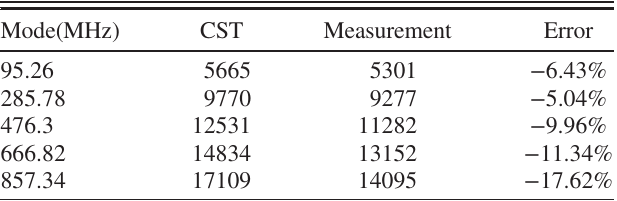
TABLE III. Unloaded quality factors from the simulation and